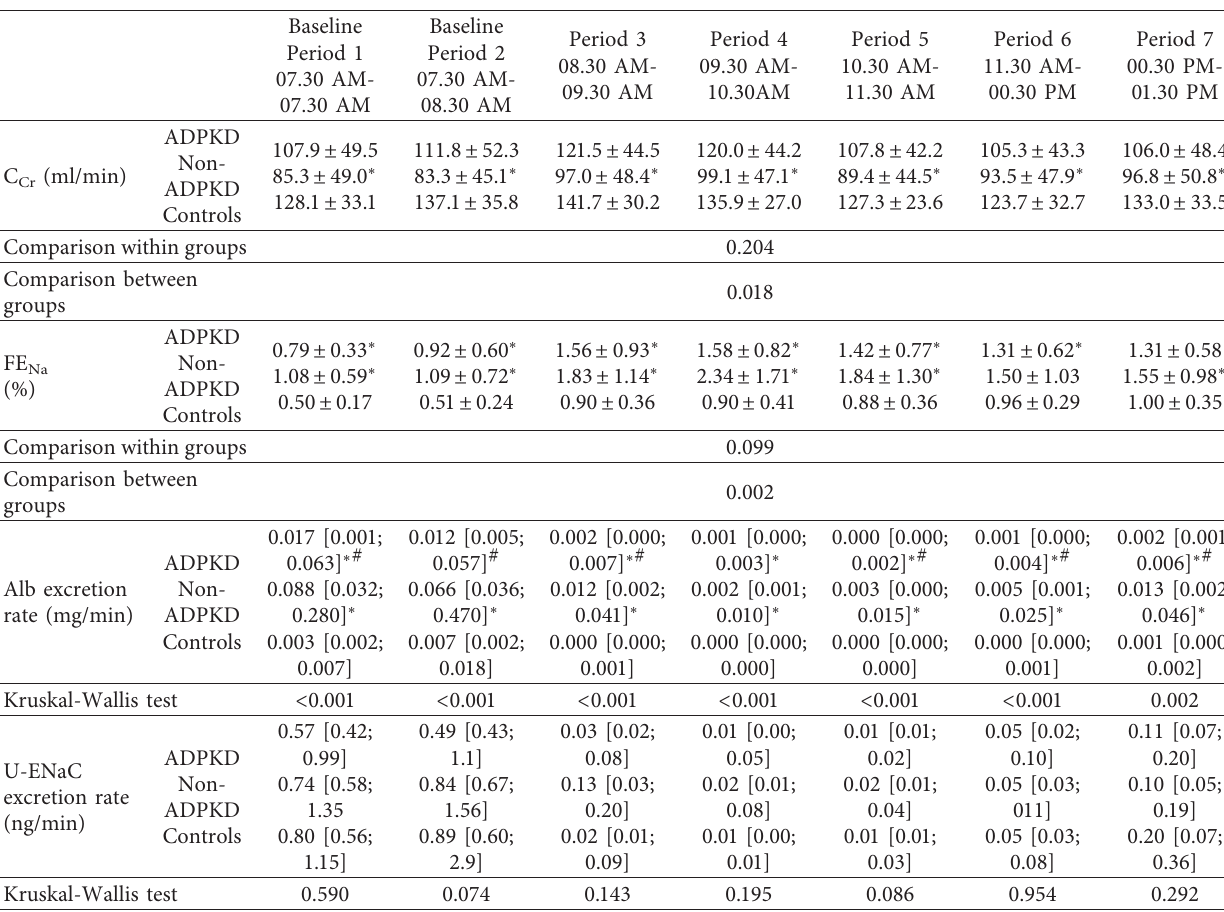
Table 3: Kidney tubular function during urine dilution test in patients with adult dominant polycystic kidney disease (ADPKD), patients with non-ADPKD kidney disease (non-ADPKD), and healthy control subjects